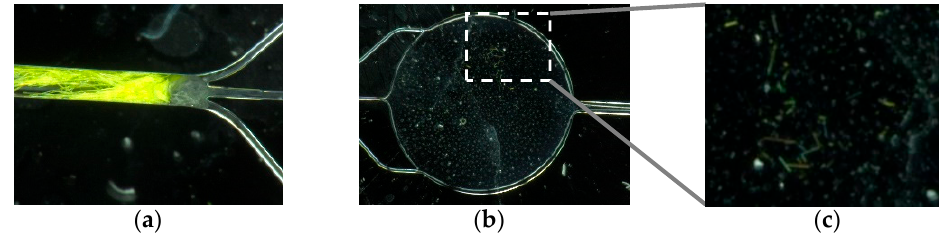
Figure 6. ( a ) Dry green DDL crystals cluster after streaming a DDL solution at a formaldehyde concentration of c 5 = 100 mg/L. ( b ) Detection chamber with ( c ) green DDL crystals on the inner walls after use of the DDL solution at a formaldehyde concentration of c 4 = 10 mg/L.